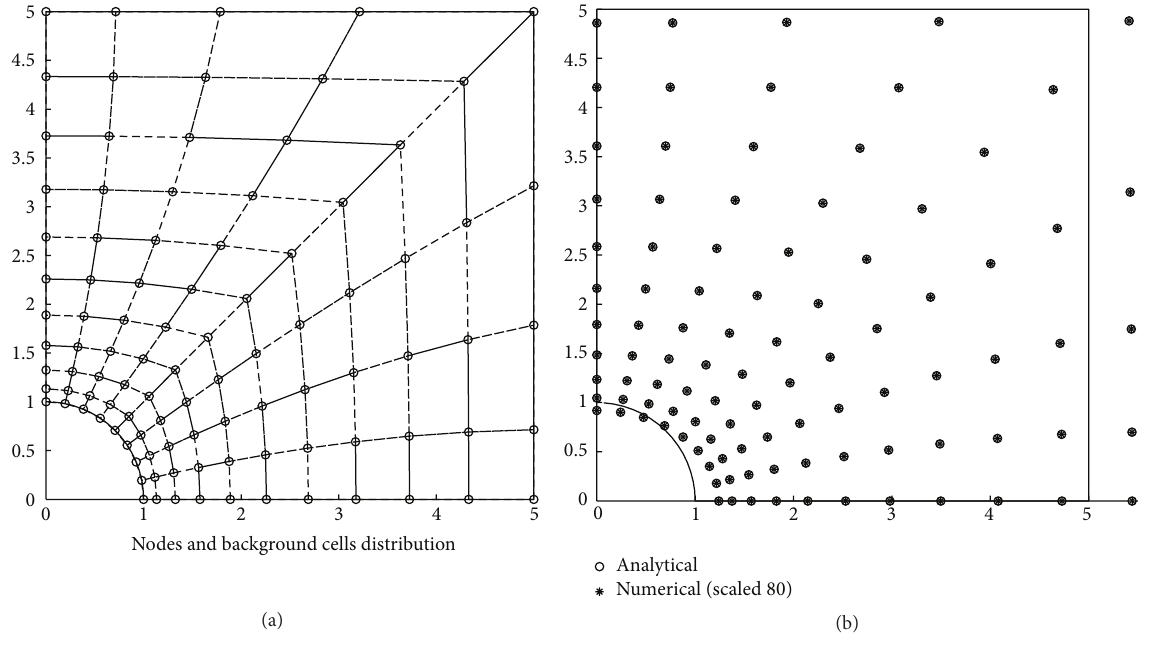
Figure 12: Plate with a central circular hole: (a) 99 nodes’ distribution, (b) analytical and RGD solution of displacement.